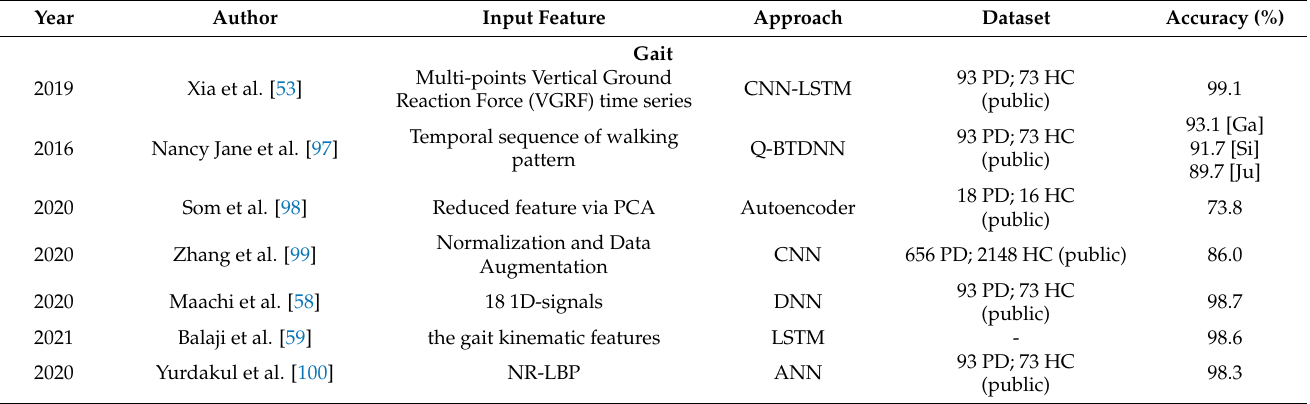
Table A2. List of deep learning studies for various modalities in motor